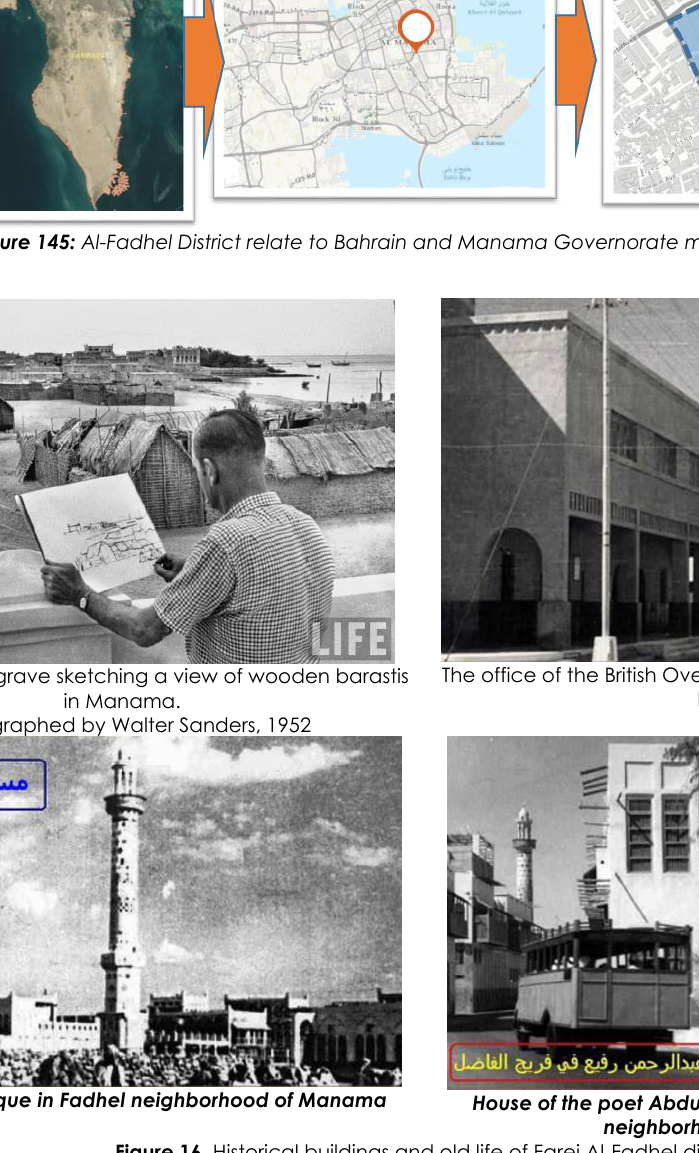
Figure 16. Historical buildings and old life of Farej Al-Fadhel district